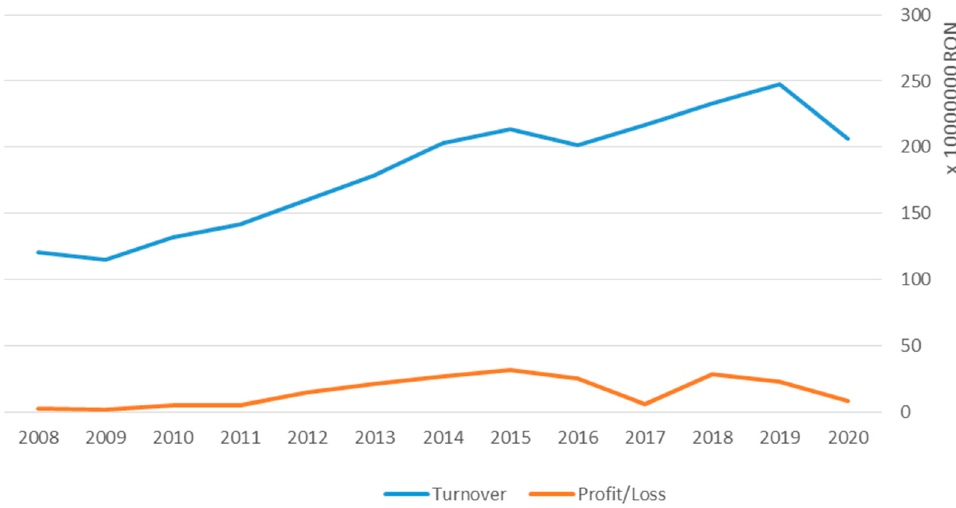
Figure 7. Profit/loss vs turnover (Source: authors based on historical data).